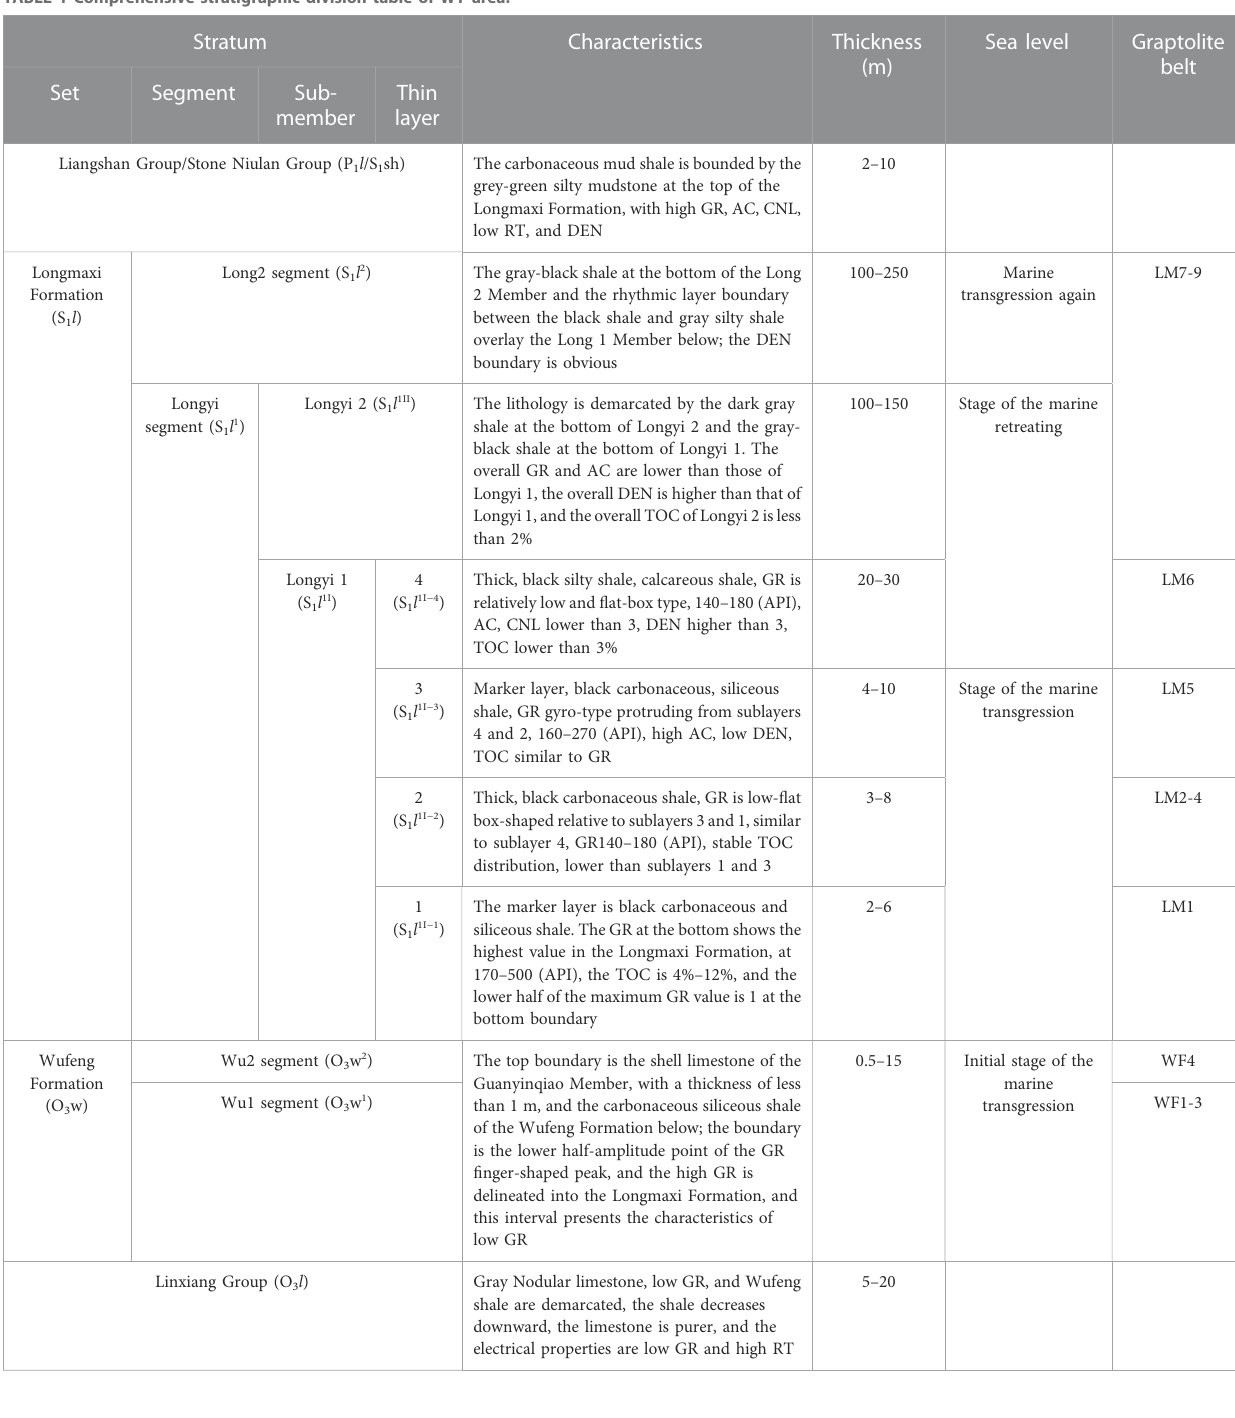
TABLE 1 Comprehensive stratigraphic division table of WY area. Stratum